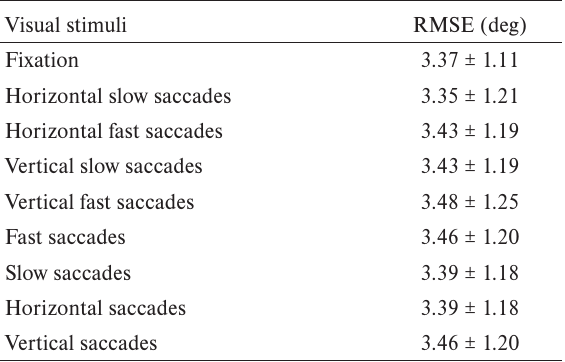
Descriptive results for all visual conditions, different speeds and directions of saccades (stated as mean ± SD) Visual stimuli RMSE (deg)